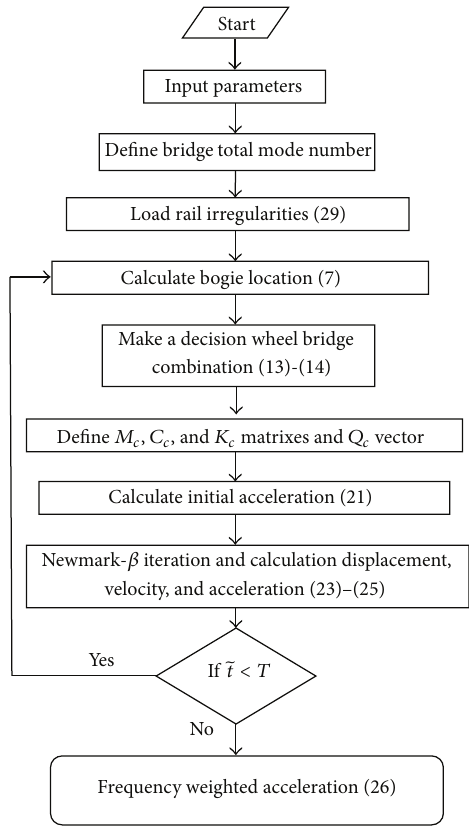
Figure 3: Flowchart of the numerical method.